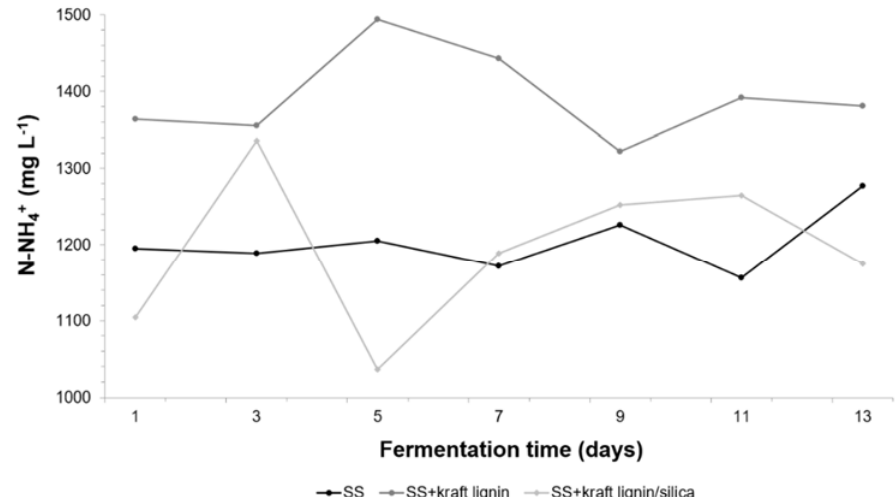
Figure 13. Changes in pH and the VFA/TA ratio during the anaerobic digestion of the SS, SS + kraft lignin and SS + kraft lignin/silica samples.